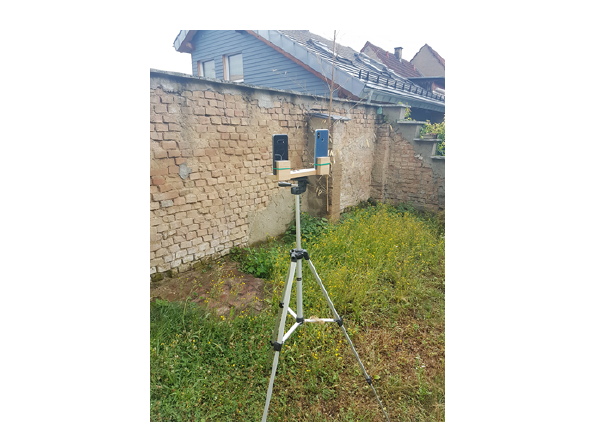
Figure 6. Tripod with both